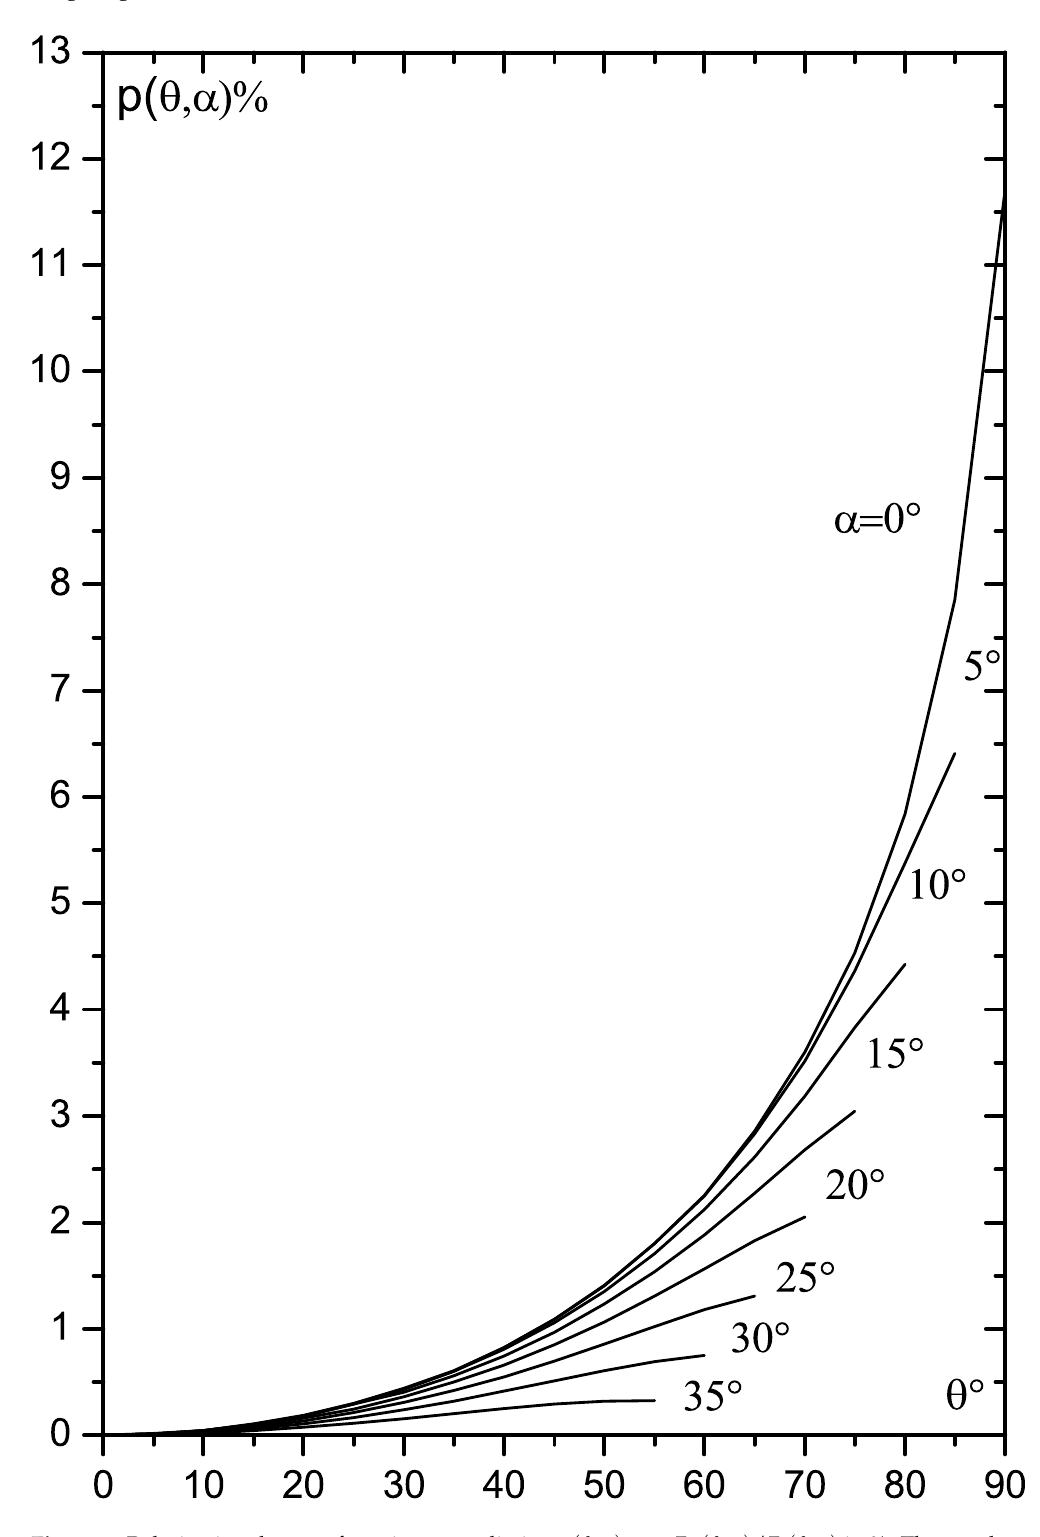
Figure 2. Polarization degree of continuum radiation p ( θ , α ) = − F Q ( θ , α ) / F I ( θ , α ) in %. The numbers denote the inclination angle α . The Stokes parameter F U ≡